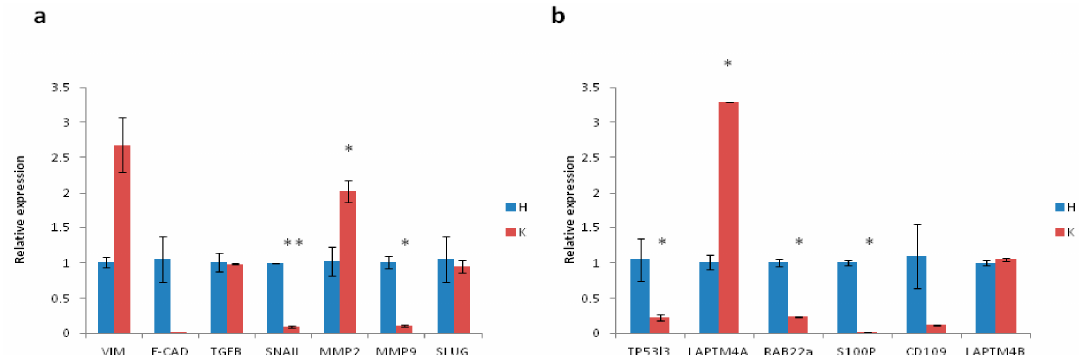
Figure 3. ( a ) Relative expression of EMT-related genes in the UPS primary culture (K) and matched healthy tissue (H); ( b ) Relative expression of chemoresistance-related genes and CD109 gene in the UPS primary culture and matched healthy tissue. Differences between groups were assessed by a two-tailed Student’s t -test, and accepted as significant * p < 0.05.